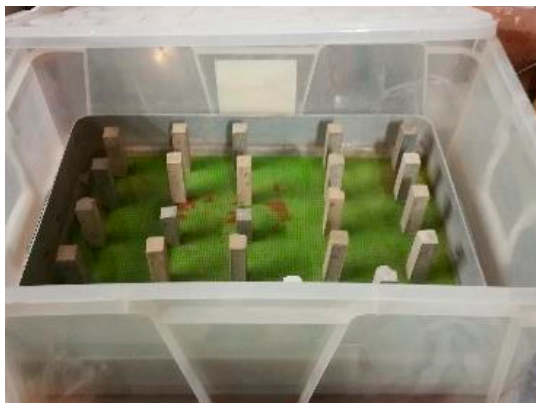
Figure 5. Box where the capillarity test took place.